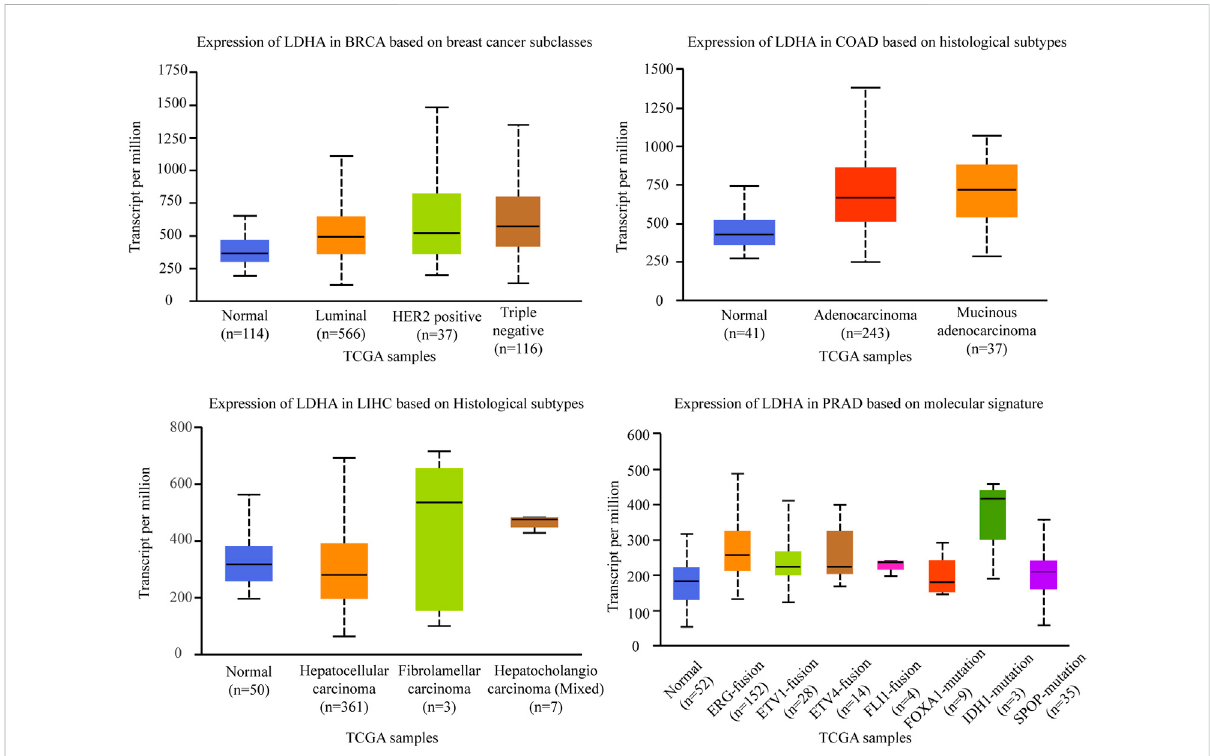
FIGURE 5 Association ofLDHA geneexpressionwith histological subtypes andmolecular signatureindifferentcancers. BRCA,breastinvasive carcinoma. COAD, colon adenocarcinoma. LIHC, liver hepatocellular carcinoma. PRAD, prostate